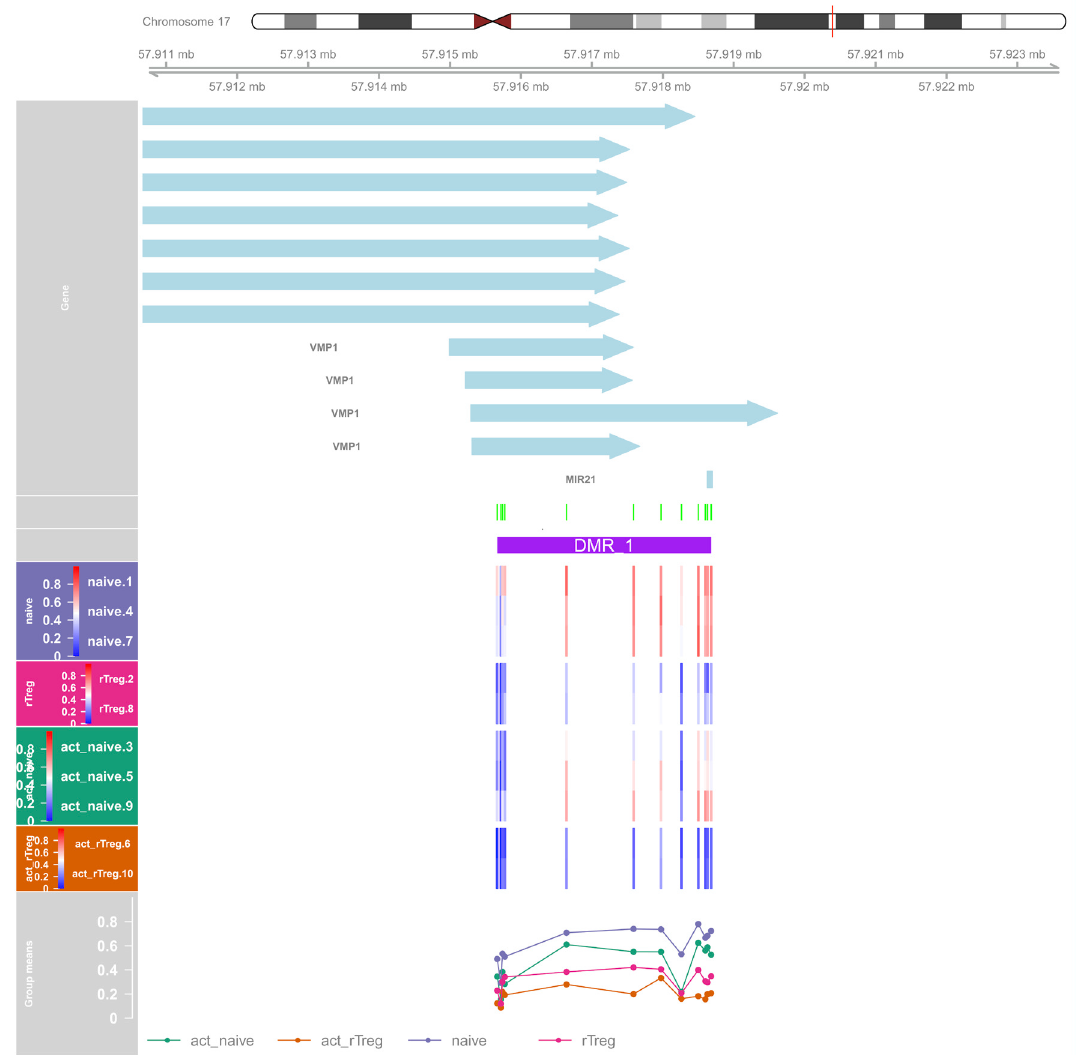
Figure 10. The DMRcate “DMR.plot” function allows you to quickly visualise DMRs in their genomic context. By default, the plot shows the location of the DMR in the genome, the position of any genes that are nearby, the base pair positions of the CpG probes, the methylation levels of the individual samples as a heatmap and the mean methylation levels for the various sample groups in the experiment. This plot shows the top ranked DMR identified by the DMRcate